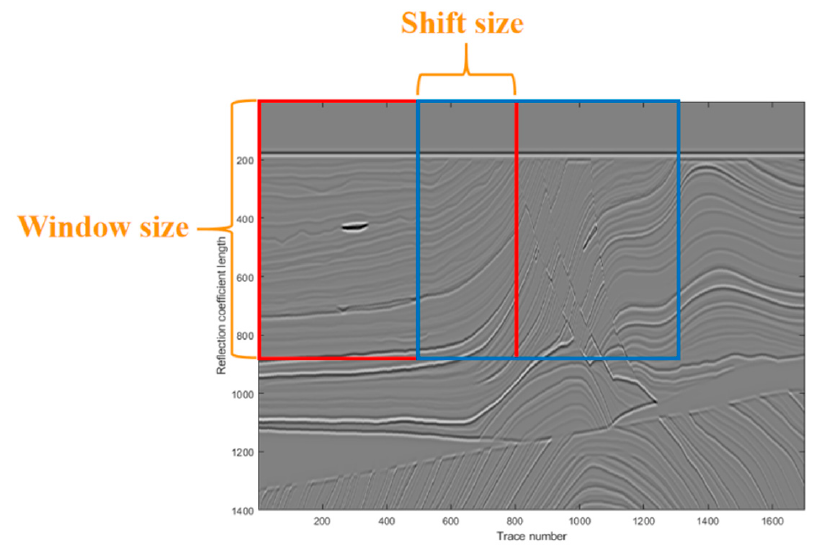
Figure 5. Sliding window method.